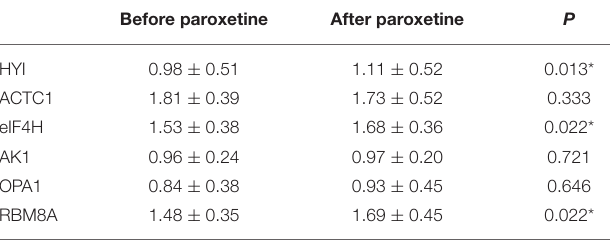
TABLE 2 | Western blot validations of potential biomarkers for paroxetine treatment response in MDD patients. Before